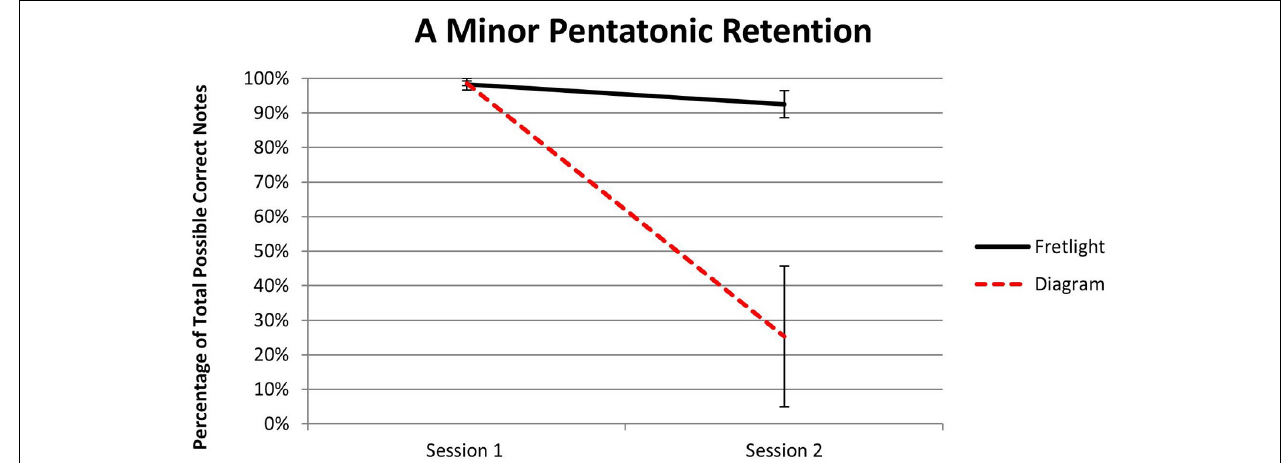
FIGURE 9 | Experiment 2 results regarding A minor pentatonic scale retention.